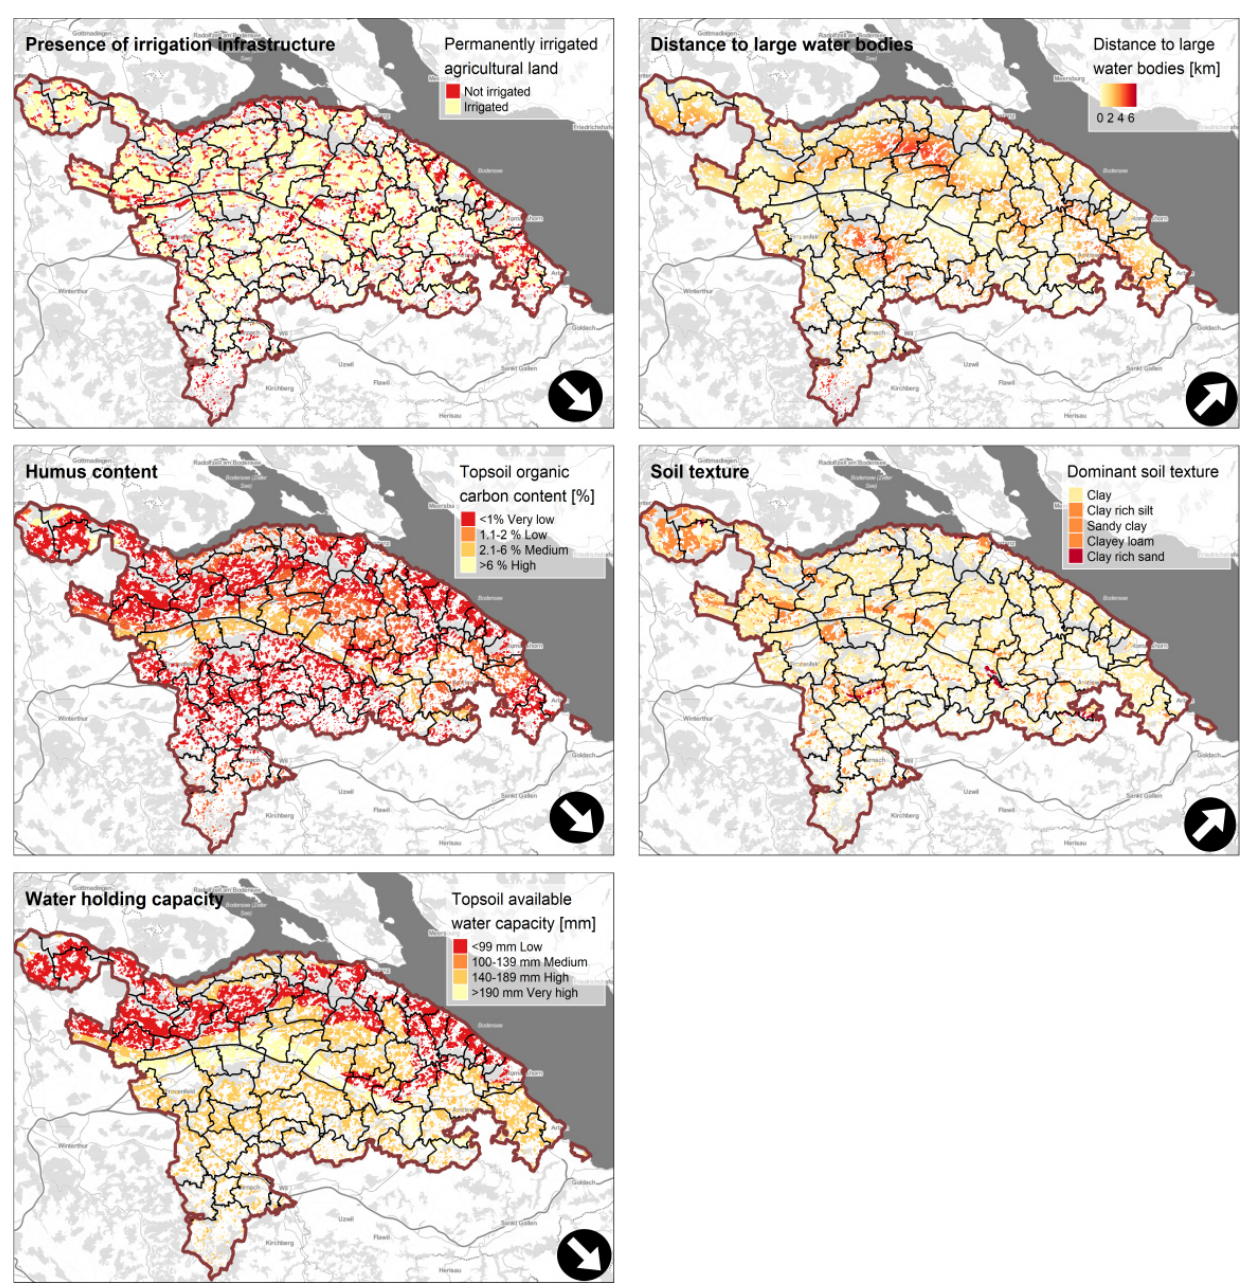
Figure 4. Thurgau’s most important factors (bold title) masked with agricultural used land and describing the regions’ vulnerability according to the experts (Fig. 3) supported by data of the indicators (see legend). The factor’s increasing or decreasing effect on the vulnerability is indicated by the arrow in the map (bottom right) and by the colour choice (the darker the colour, the higher the vulnerability). LAU2 regions are indicated by black borders and labelled when showing relatively high or low